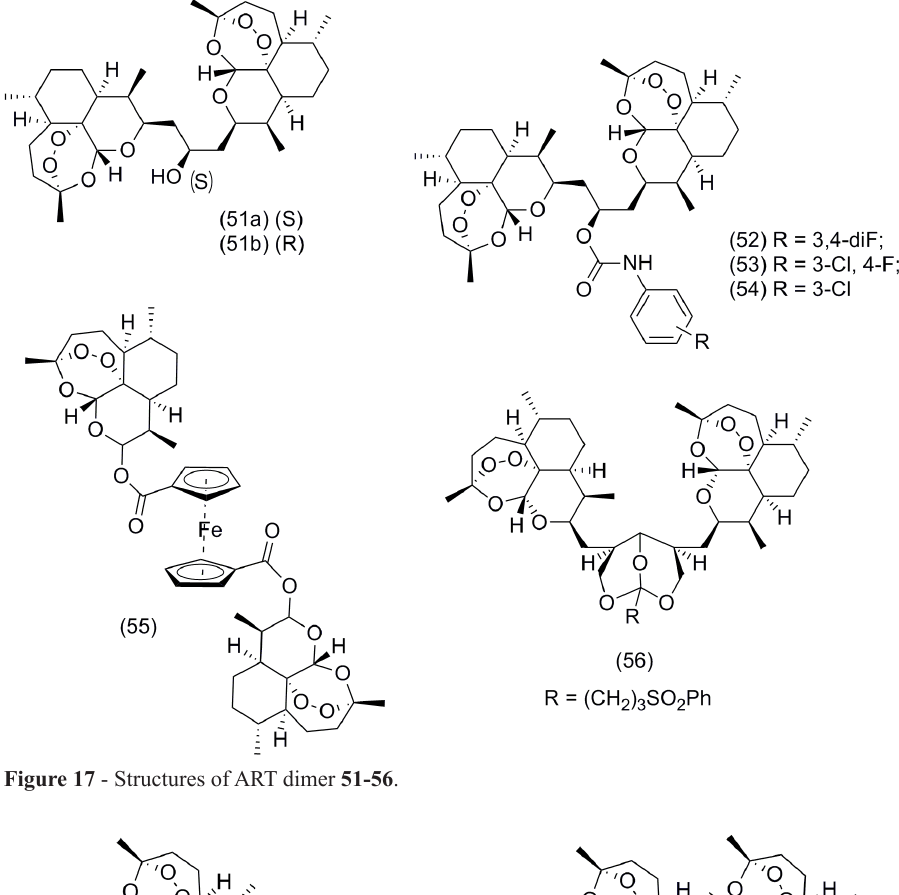
Figure 17 - Structures of ART dimer 51-56 .